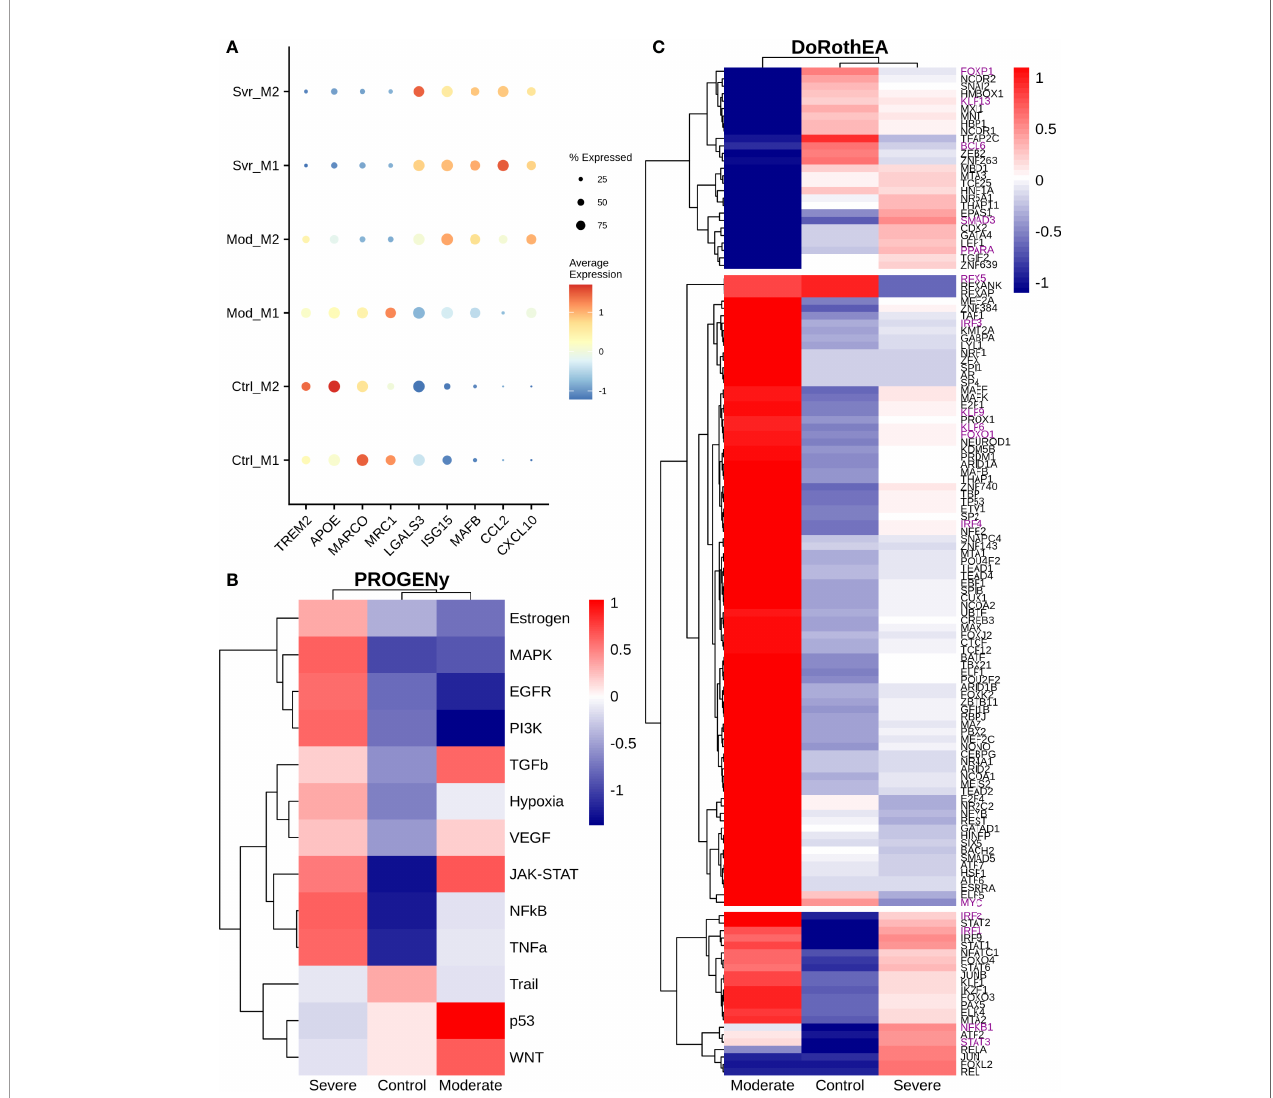
FIGURE 6 | Differential macrophage activity among patients. (A) Expression levels of in fl ammatory and fi brotic related genes, point size and colorbar represent the percentage of cells that express a gene and the average expression, respectively. (B) Pathway differential analysis among patients. (C) Transcription factors altered on macrophages among disease severity. Colorbar is related to activation/inactivation values. M1 stands for macrophage type I and M2 for macrophages type